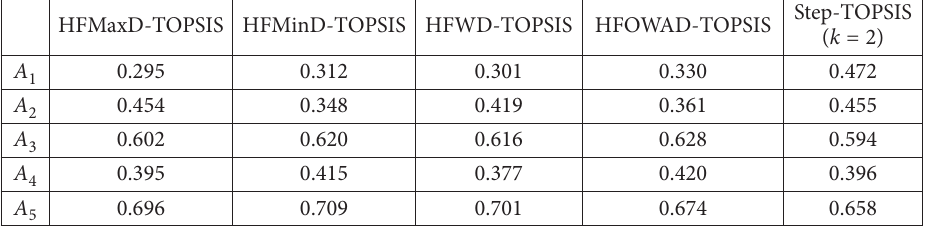
Table 4. The closeness V ( x i ) obtained by the particular cases of the HFOWAWAD-TOPSIS approach